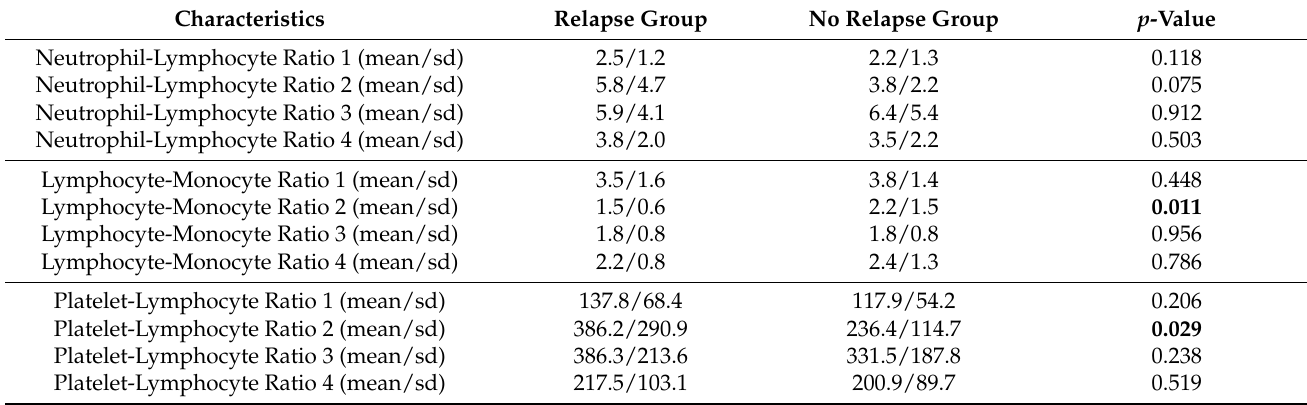
Table 3. Univariate analysis of hematologic